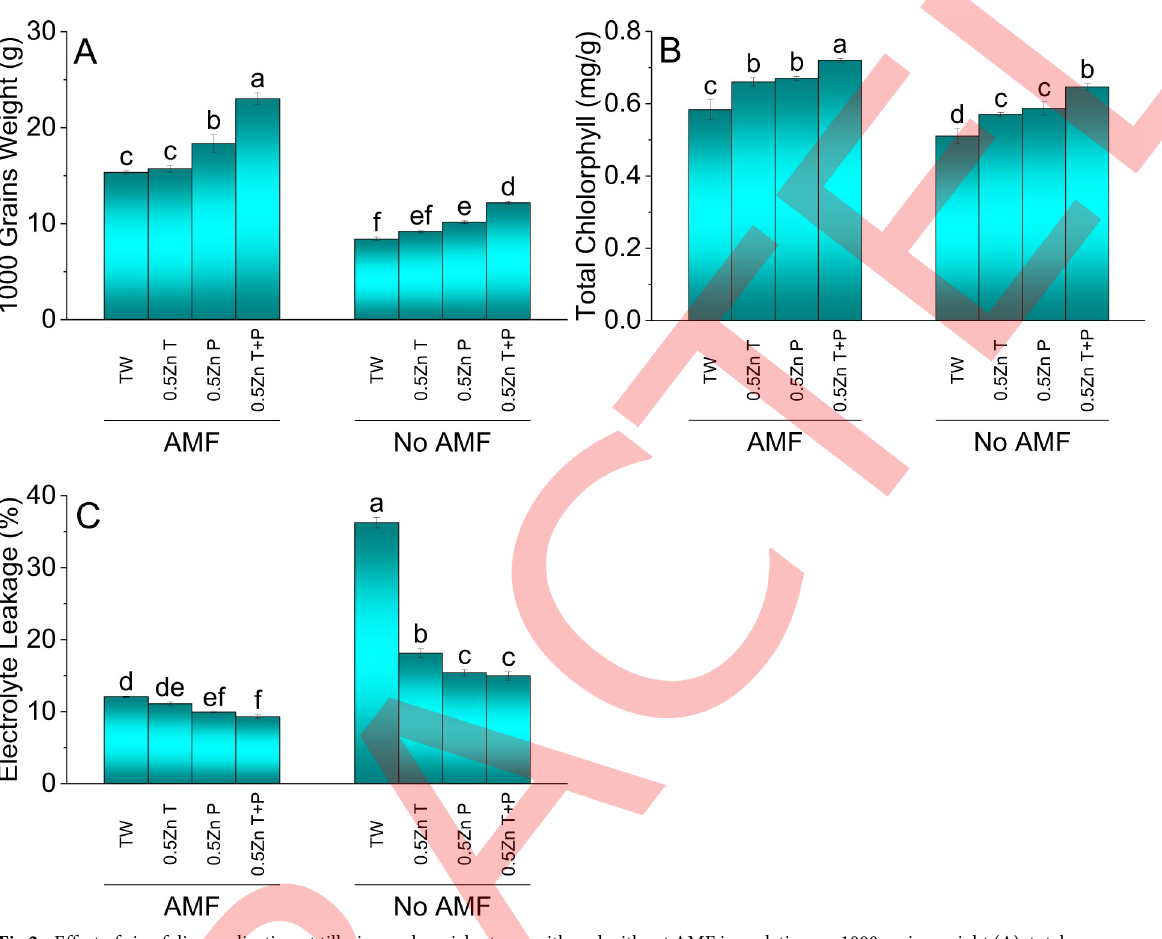
Fig 2. Effect of zinc foliar application at tillering and panicle stages with and without AMF inoculation on 1000 grains weight (A), total chlorophyll (B) and electrolyte leakage (C) in rice leaves. Bars are means of three replicates ± SE. Variable letters on bars indicate significant difference at p � 0.05 according to LSD test. TW = tap water (control); T = tillering stage; P = panicle stage; Zn = zinc.